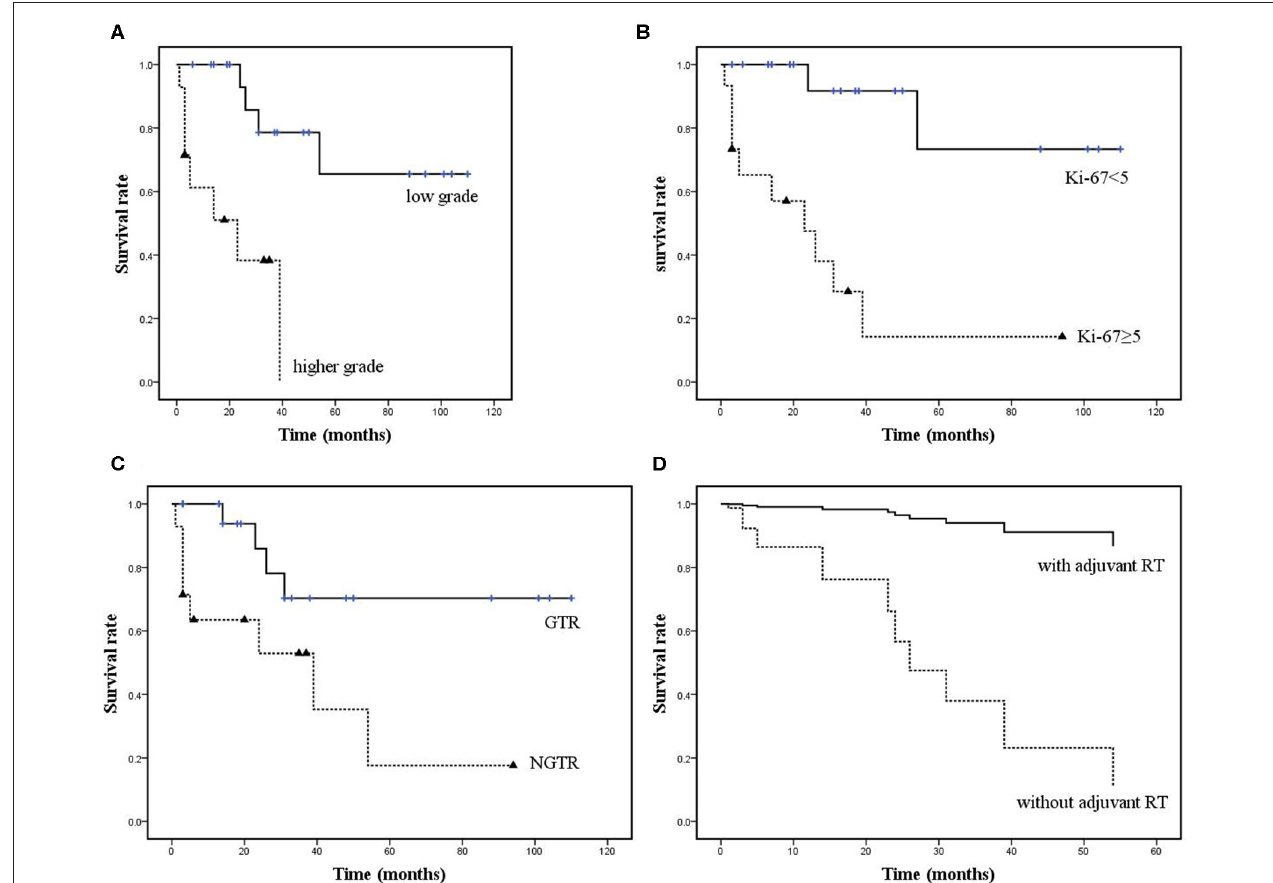
FIGURE 8 | (A–C) Kaplan-Meier curves showing statistically significant differences in PFS based on histological grade, Ki-67 LI and EOR ( P = 0.001, P < 0.001, and P = 0.024, respectively). (D) Adjuvant RT was also significantly associated with PFS on multivariate analysis ( P = 0.024, HR: 15.632, 95% CI: